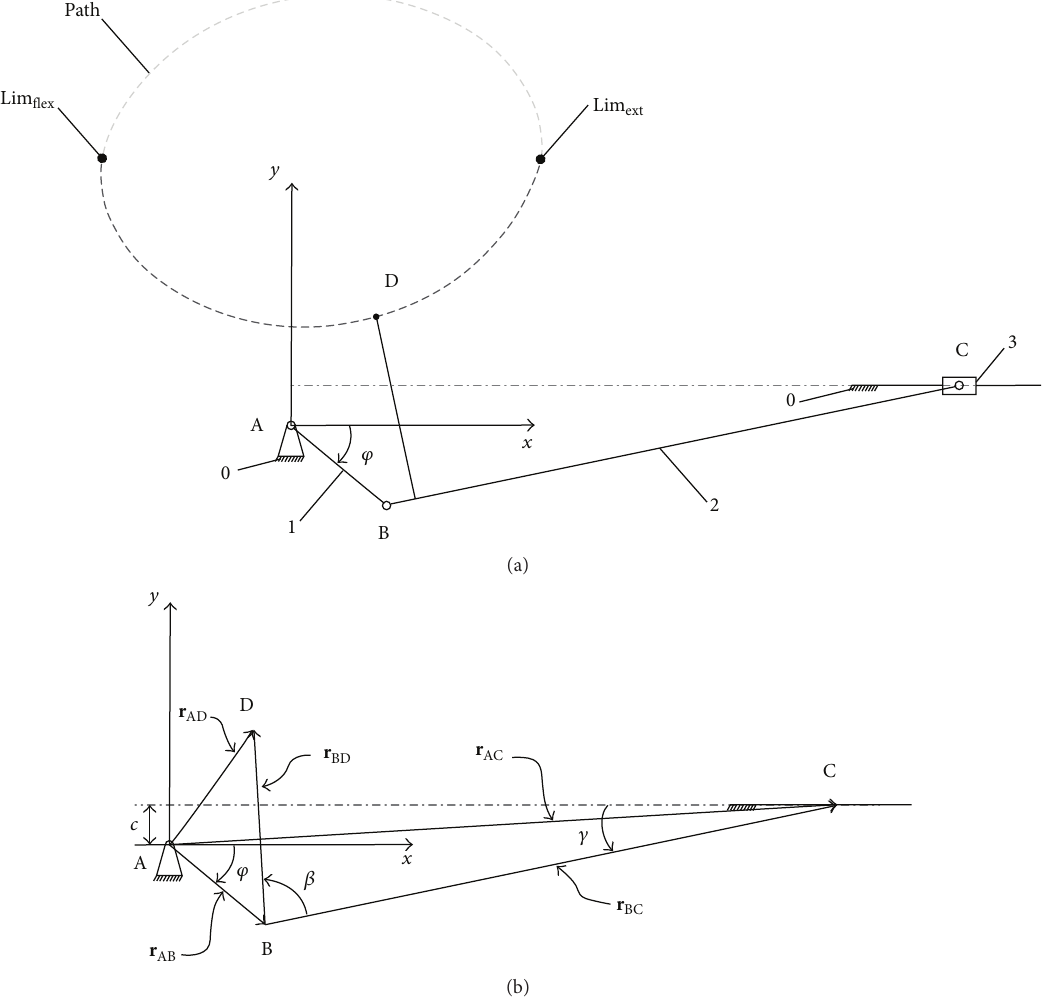
Figure 4: R-RRT mechanism: (a) scheme and (b) vector analysis.